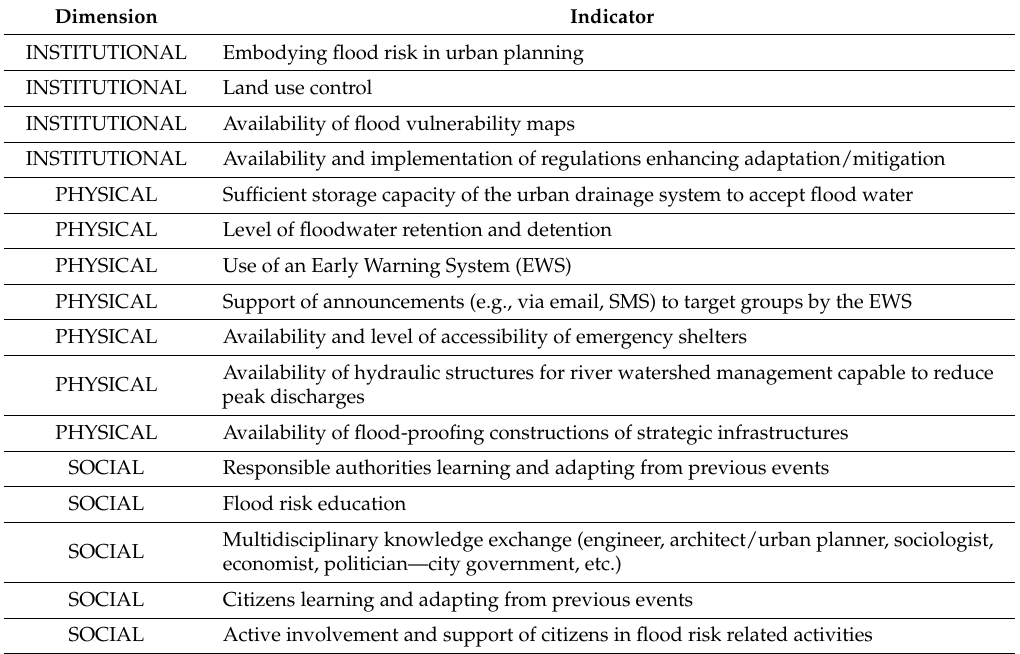
Table 2. Indicators rated with the highest weighting factor and showing low variability for the fluvial/pluvial flood type.